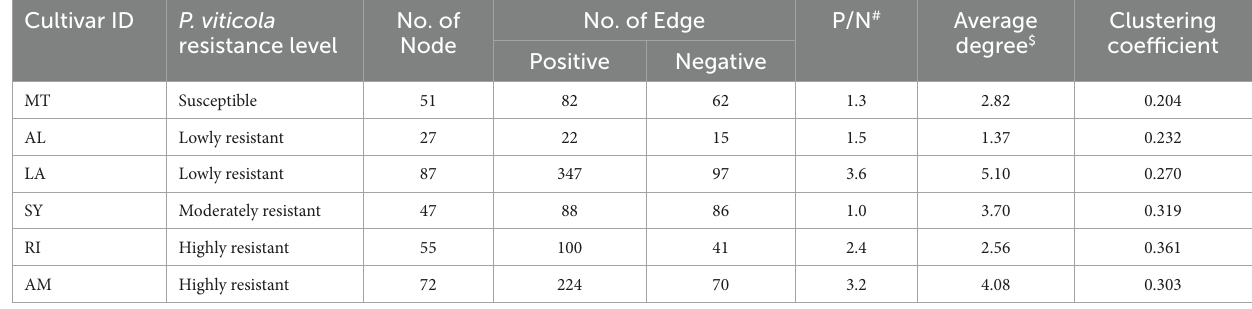
TABLE 2 Network topological properties of different grapevine cultivars. Cultivar